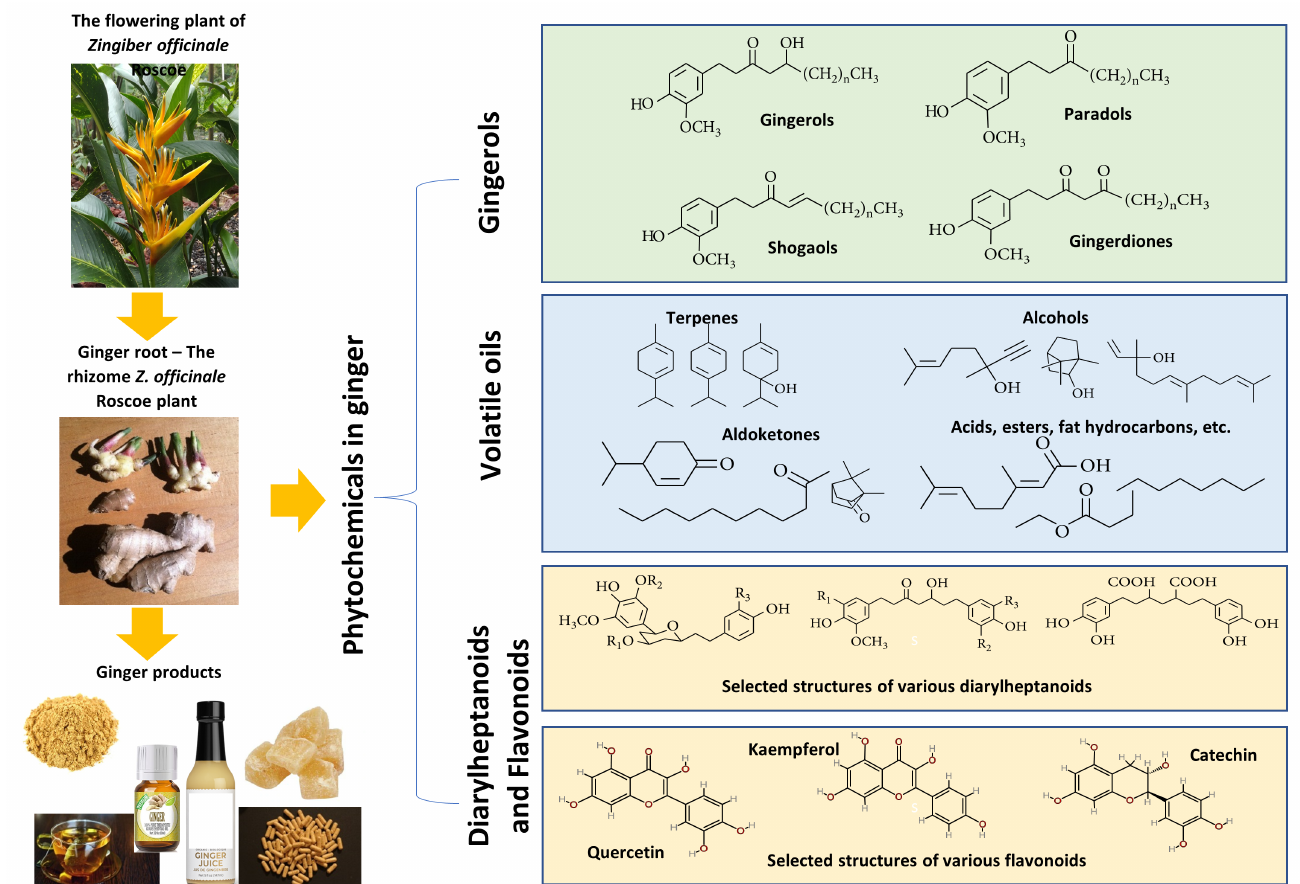
Figure 1. An overview of ginger and its main groups of active constituents of gingerols, volatile oils, diarylheptanoids, and flavanoids with some sample structural formulas. In the formulas of gingerols, n denotes the number of repeating units of CH 2 . R 1 , R 2 , and R 3 in the selected diarylheptanoid structures are sites for functional groups or substituents (e.g., H, CH 3 , OCH 3 , or COCH 3